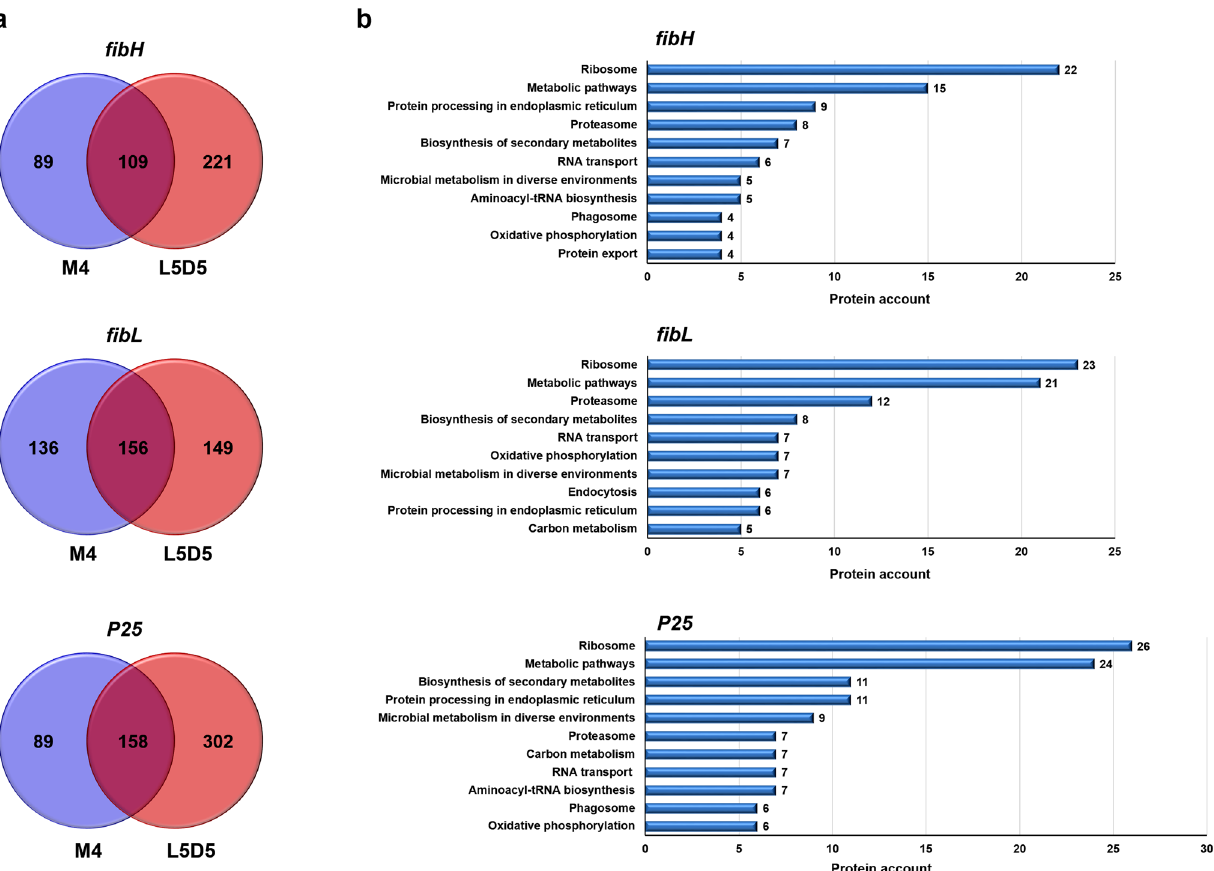
Figure 2. Overlap between the PIPs of each fibroin gene in M4 and L5D5. ( a ) Venn diagrams showing the numbers of common and unique PIPs of the fibH , fibL , and P25 genes. ( b ) KEGG pathway enrichment of common PIPs. Top 10 KEGG pathways that excludes those related to human diseases are